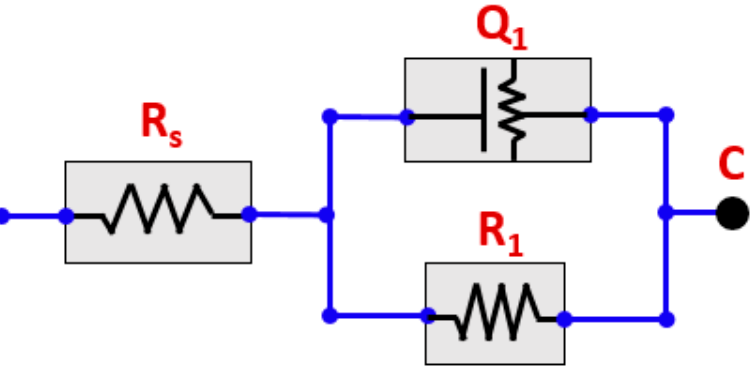
Figure 8. Equivalent circuit diagram for EIS fitting.